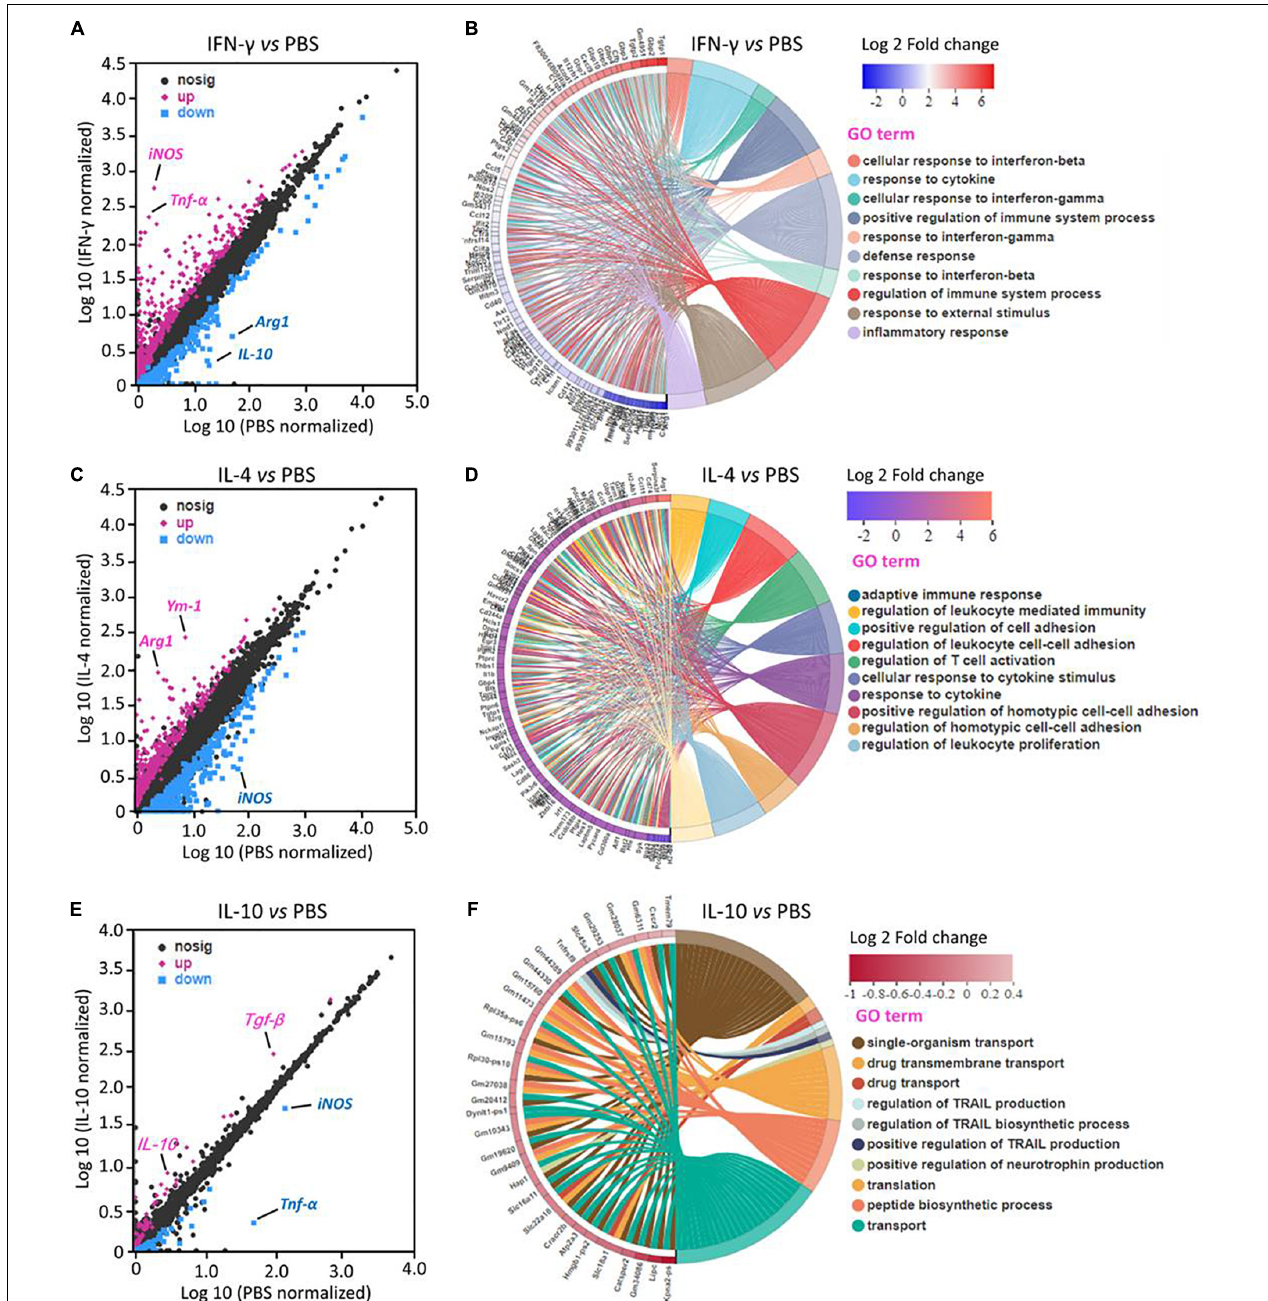
FIGURE 1 | Transcriptional profiling of primary microglia treated with IFN- γ , IL-4, or IL-10. (A,C,E) Differentially expressed genes (DEGs) in primary microglia following treatment with IFN- γ , IL-4, or IL-10. Red DEGs are upregulated; blue DEGs, downregulated. (B,D,F) Enrichment of DEGs in Gene Ontology categories ( n = 3).